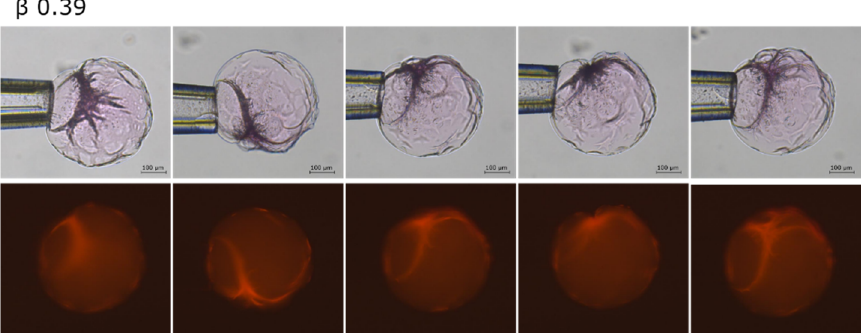
Figure 4. AMT distribution in a polyacrylate microgel after equilibration at binding ratio β = 0.39. Images taken at different angles by rotating the gel holder.